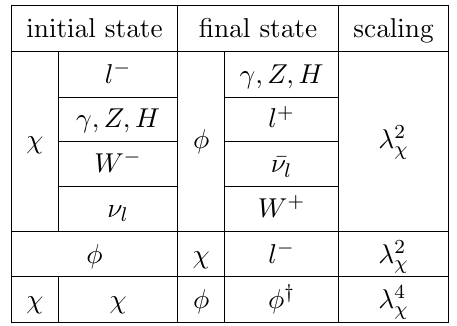
and (cid:21) 4 . (cid:31) (cid:31)